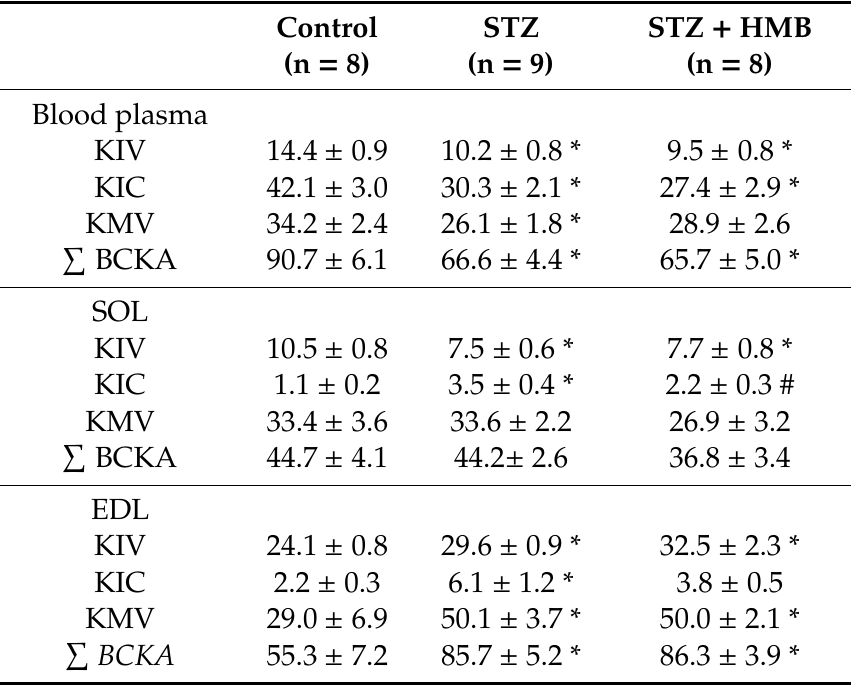
Table 7. Concentrations of branched-chain keto acids